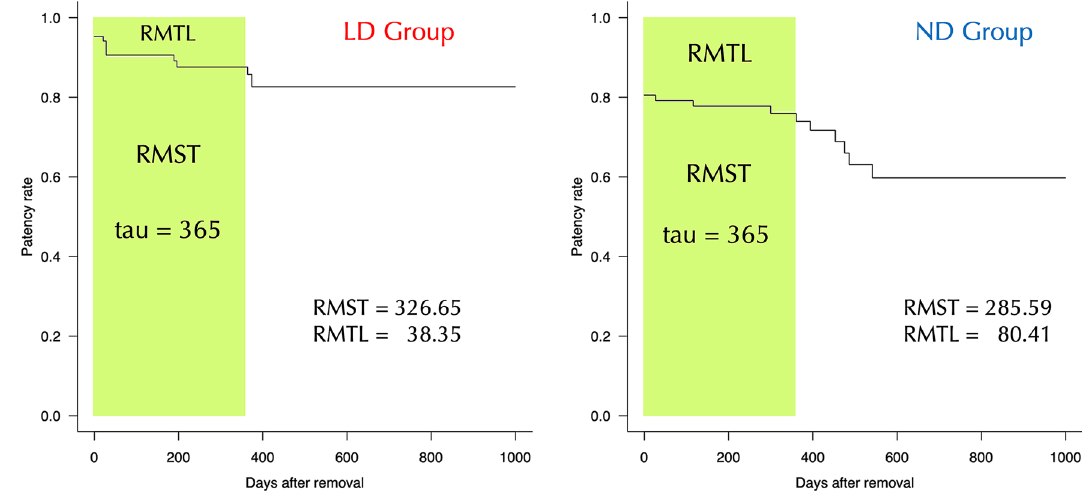
Figure 5. Comparison of survival rates between the two groups at 1 year after tube removal by the RMST method. RMST and RMTL are the areas under and over the Kaplan–Meier survival curve, respectively. The RMST and RMTL in the LD and ND groups with τ = 365 days were 326.65, 284.59, 38.35, and 80.41, respectively. RMST (LD) − (ND) = 42.058 (95% CI: 0.996, 83.121, p = 0.045), RMST (LD)/(ND) = 1.148 (95% CI: 0.999, 1.319, p = 0.052), and RMTL (LD)/(ND) = 0.477 (95% CI: 0.230, 0.988, p = 0.046). The y -axis denotes the patency rate, and the x -axis shows the number of days after tube removal. Abbreviation: RMST, restricted mean survival time; RMTL, restricted mean time